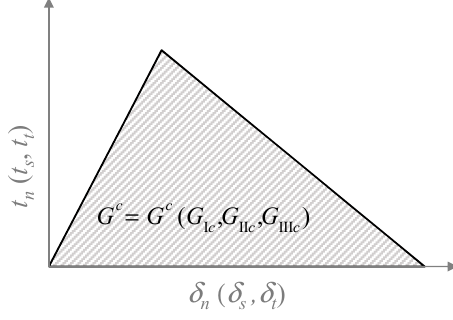
Figure 6. Linear softening scheme adopted in the present study.